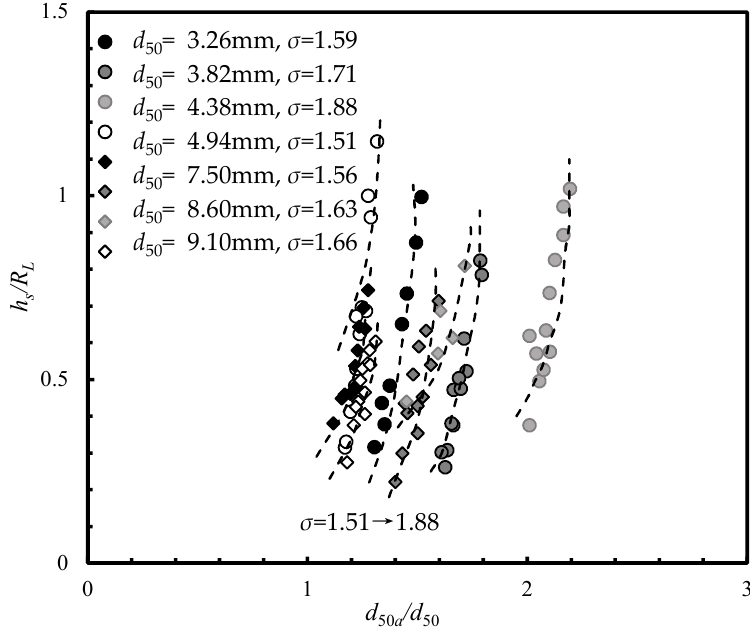
Figure 4. Dimensionless scour depth variation with armor ratio.